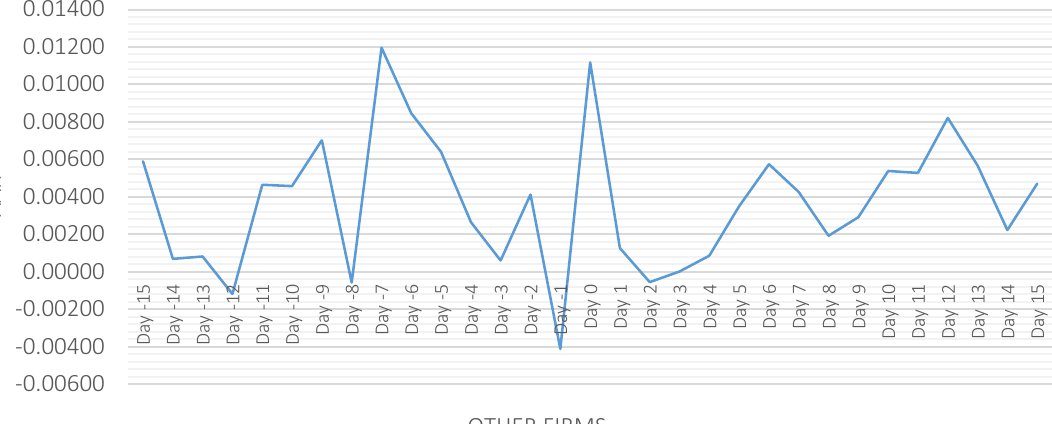
Figure 6. Average Abnormal Returns (AAR) of other firms